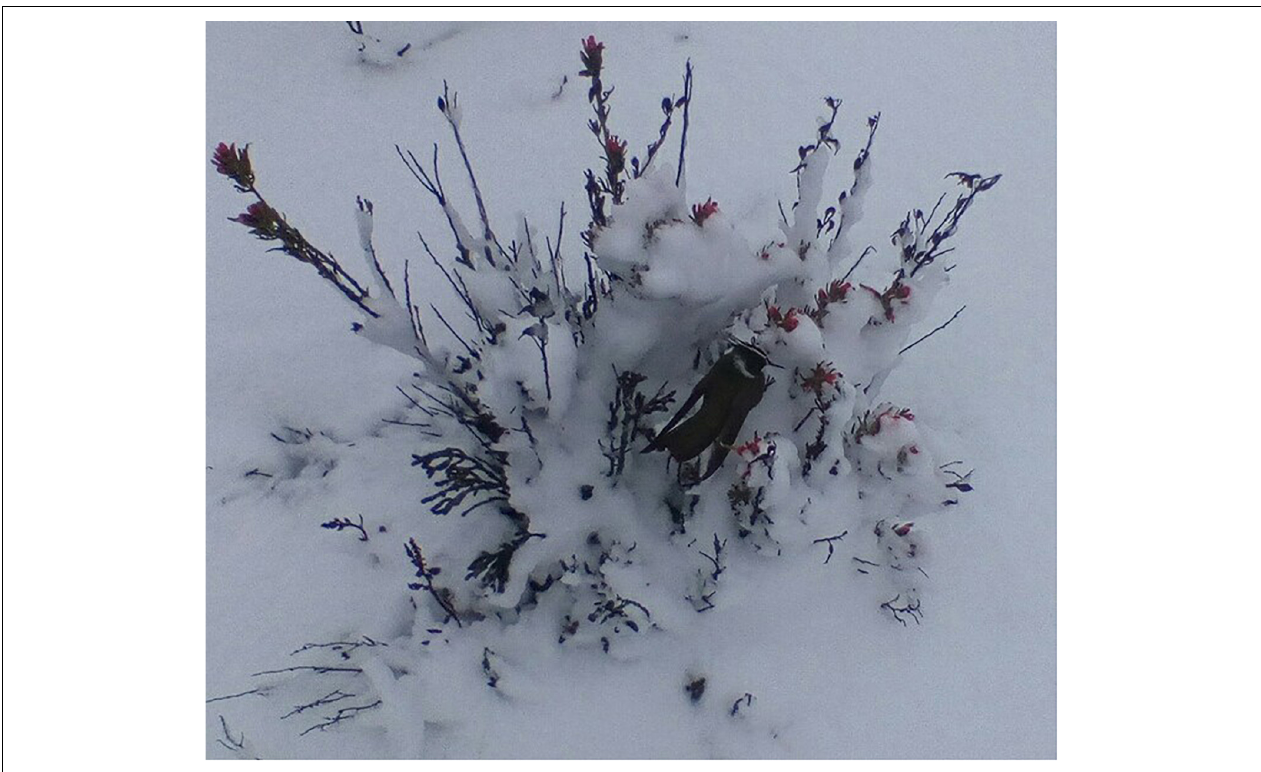
FIGURE 7 | Oxypogon lindenii (Trochilidae) visiting flowers of Castilleja fissifolia (Orobanchaceae) during a snowfall event at 4,400 m in the Venezuelan superpáramo.